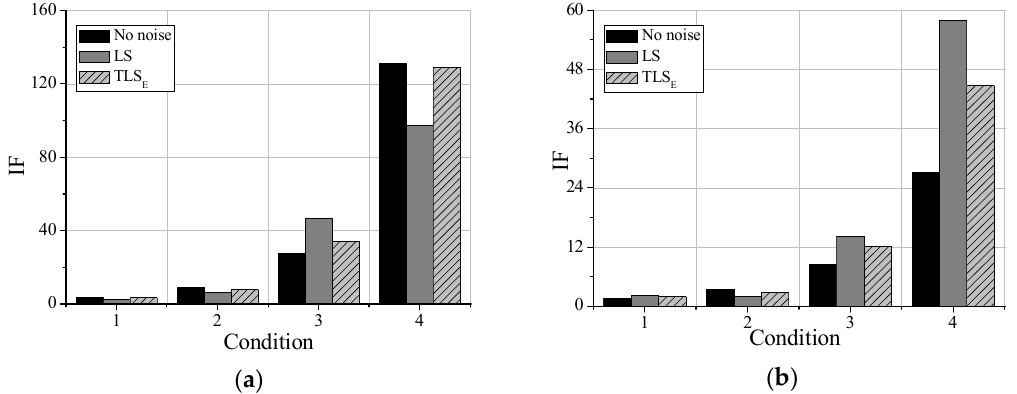
Figure 5. Damage identification results ( a ) Point 4; ( b ) Point 6.